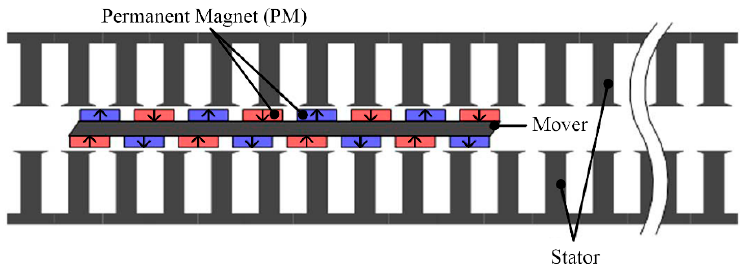
Figure 4. Structure of a double-sided long-stator-type permanent magnet linear synchronous mo- tor (PMLSM). Reprinted with permission from ref. [43]. Copyright 2014 IEEE.